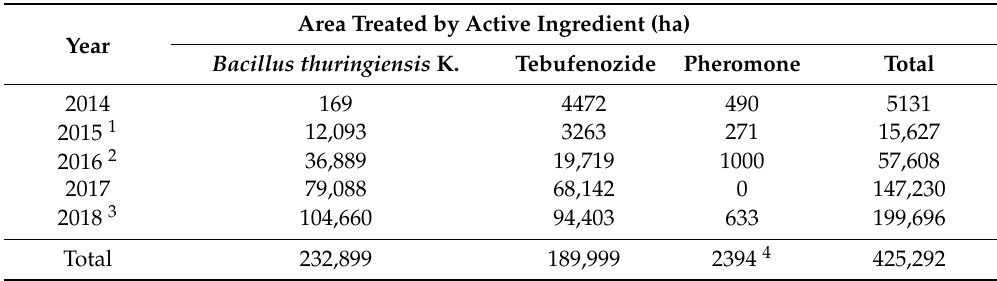
Figure 5. Areas treated with insecticides ( Btk or tebufenozide), or pheromone in EIS SBW trials each year from 2014 to 2018 in New Brunswick. Table 2. Area treated by active ingredient during the EIS-SBW Project (2014–2018).